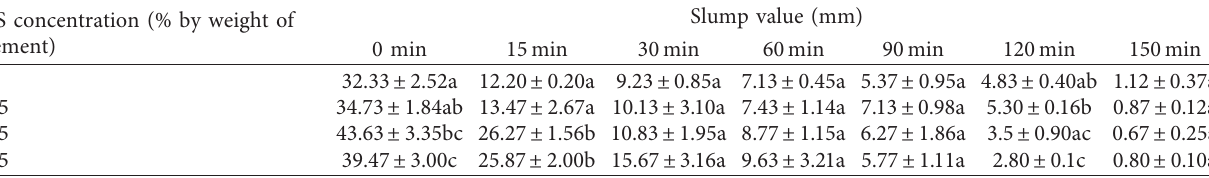
Table 3: Slump values of CEM I based mortars with biosurfactant (BS) concentrations of 0%, 0.5%, 1.5%, and 2.5%. BS concentration (% by weight of